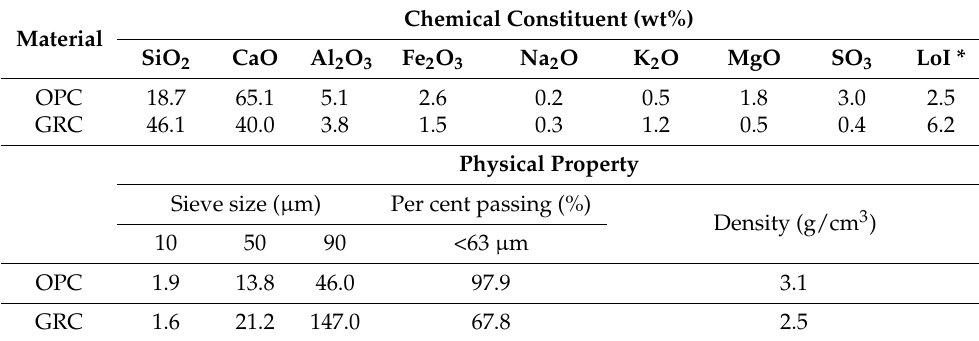
Table 1. Chemical constituents and physical properties of OPC and GRC.